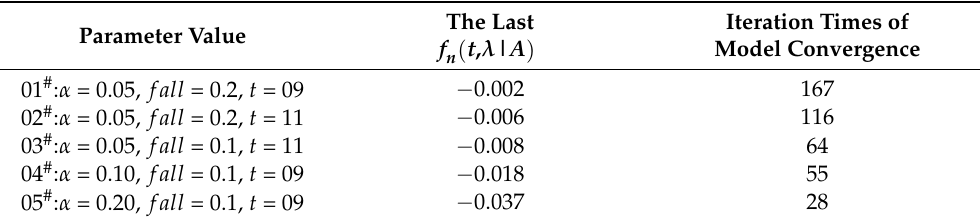
Table 1. The number of iterations required for the convergence of the model when the data update time is always later than the set period ( T =